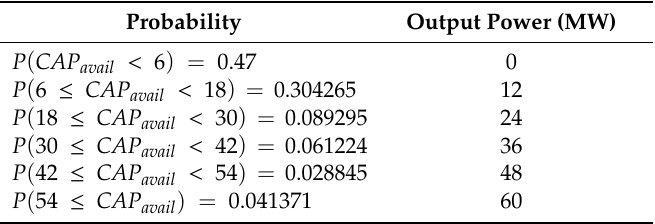
Table 4. Sixty-megawatt farm output model for FOR =